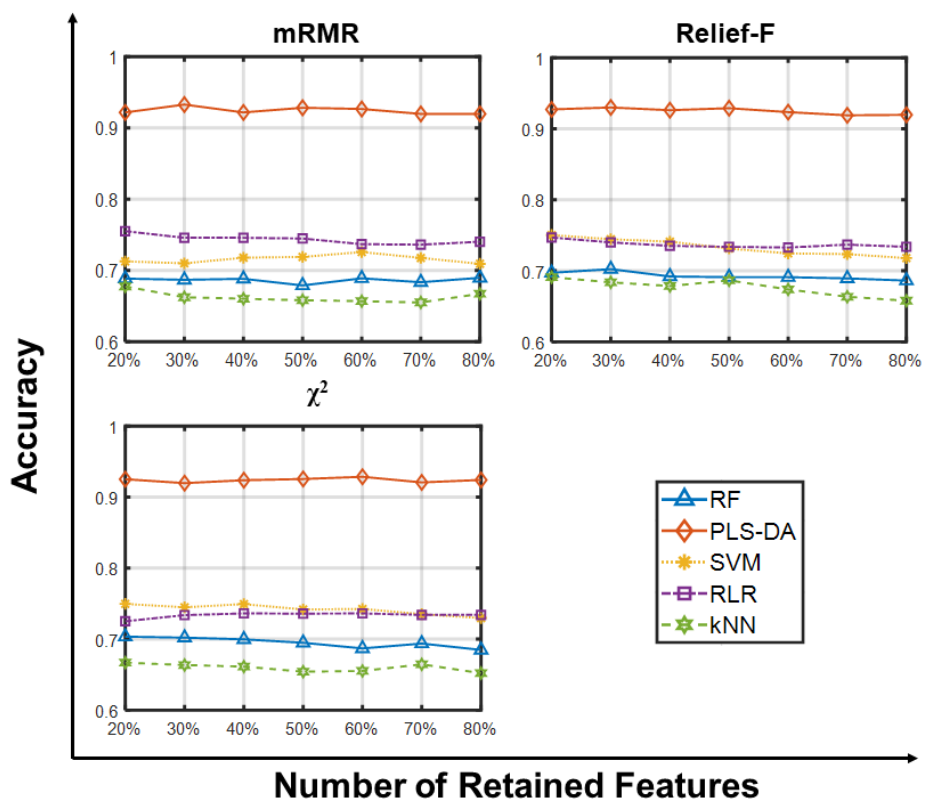
Figure 2. Predictive accuracy retaining larger sets of features on SMK_CAN_187. Predictive accuracies of RF, PLS-DA, SVM, RLR and kNN vs. Number of Retained Features (20, 30, 40, 50, 60, 70, 80% of the whole gene set) on the SMK_CAN_187 dataset using three feature selection methods. Each point is the average predictive accuracy computed over 100 resamplings.